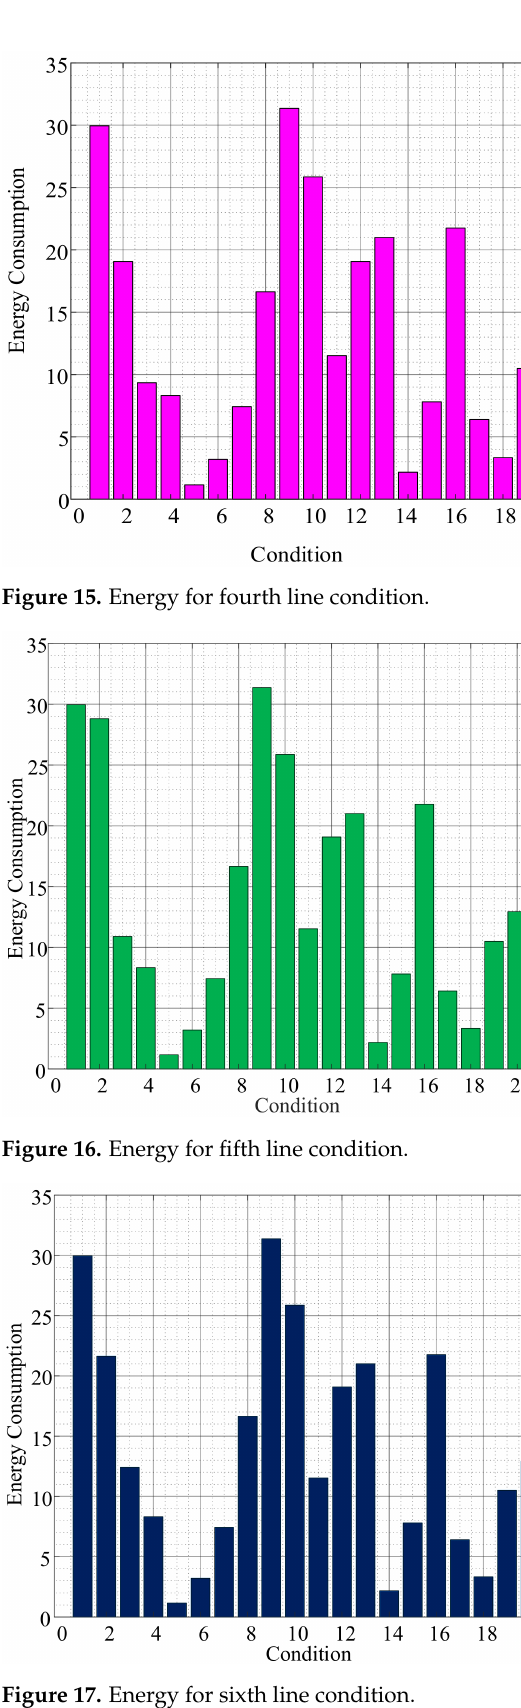
Figure 17. Energy for sixth line